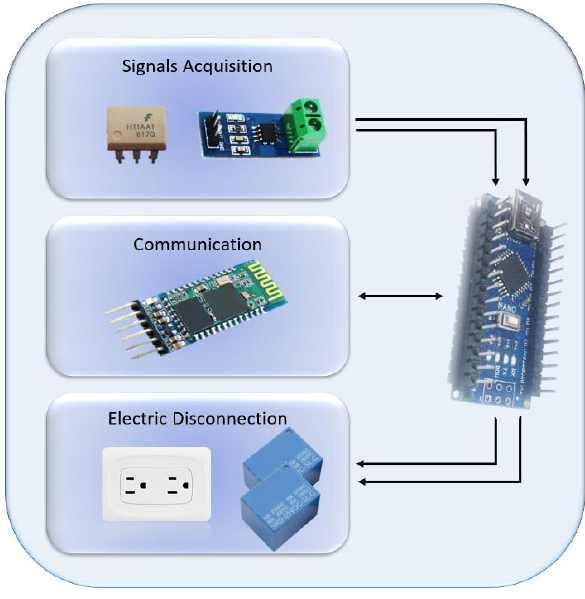
Figure 2. General scheme of a